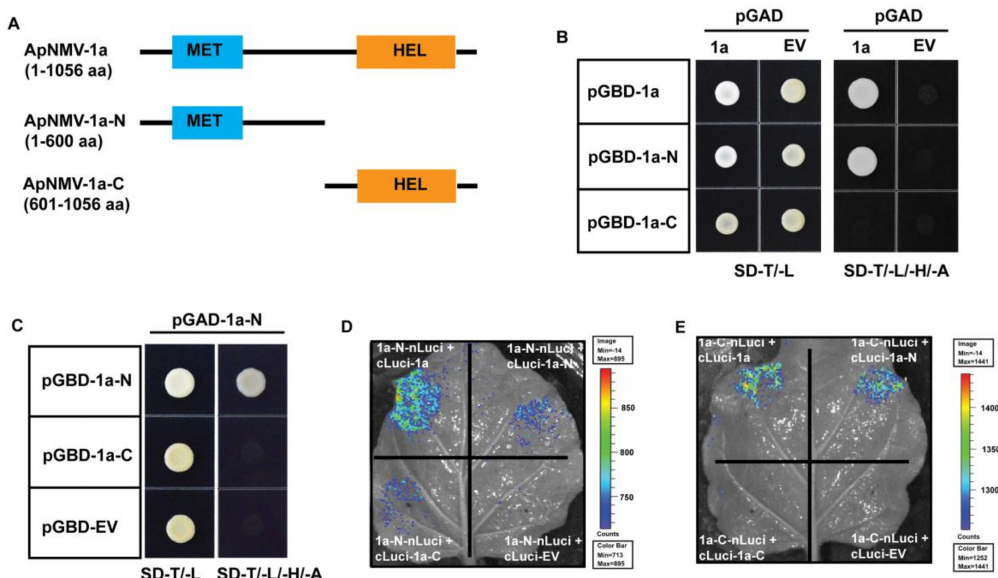
Figure 4. The N-terminal of 1a protein plays a key role in 1a’s intramolecular interactions. ( A ) The schematic model of split 1a protein based on the methyltransferase (MET) and helicase (HEL) domains. A yeast-two-hybrid assay suggested the existence of interactions between 1a and its N-terminal ( B ), and N-terminal with itself ( C ). ( D ) A luciferase complementation imaging assay indicated the existence of interactions of the 1a-N terminal with itself and also the 1a C-terminal. ( E ) The luciferase complementation imaging also assay suggested the interaction of the 1a C-terminal with full-length 1a and the 1a N-terminal. Empty vector (EV) served as a negative control. The bar on the right side of (D) and (E) indicated the signal intensity captured by the imaging